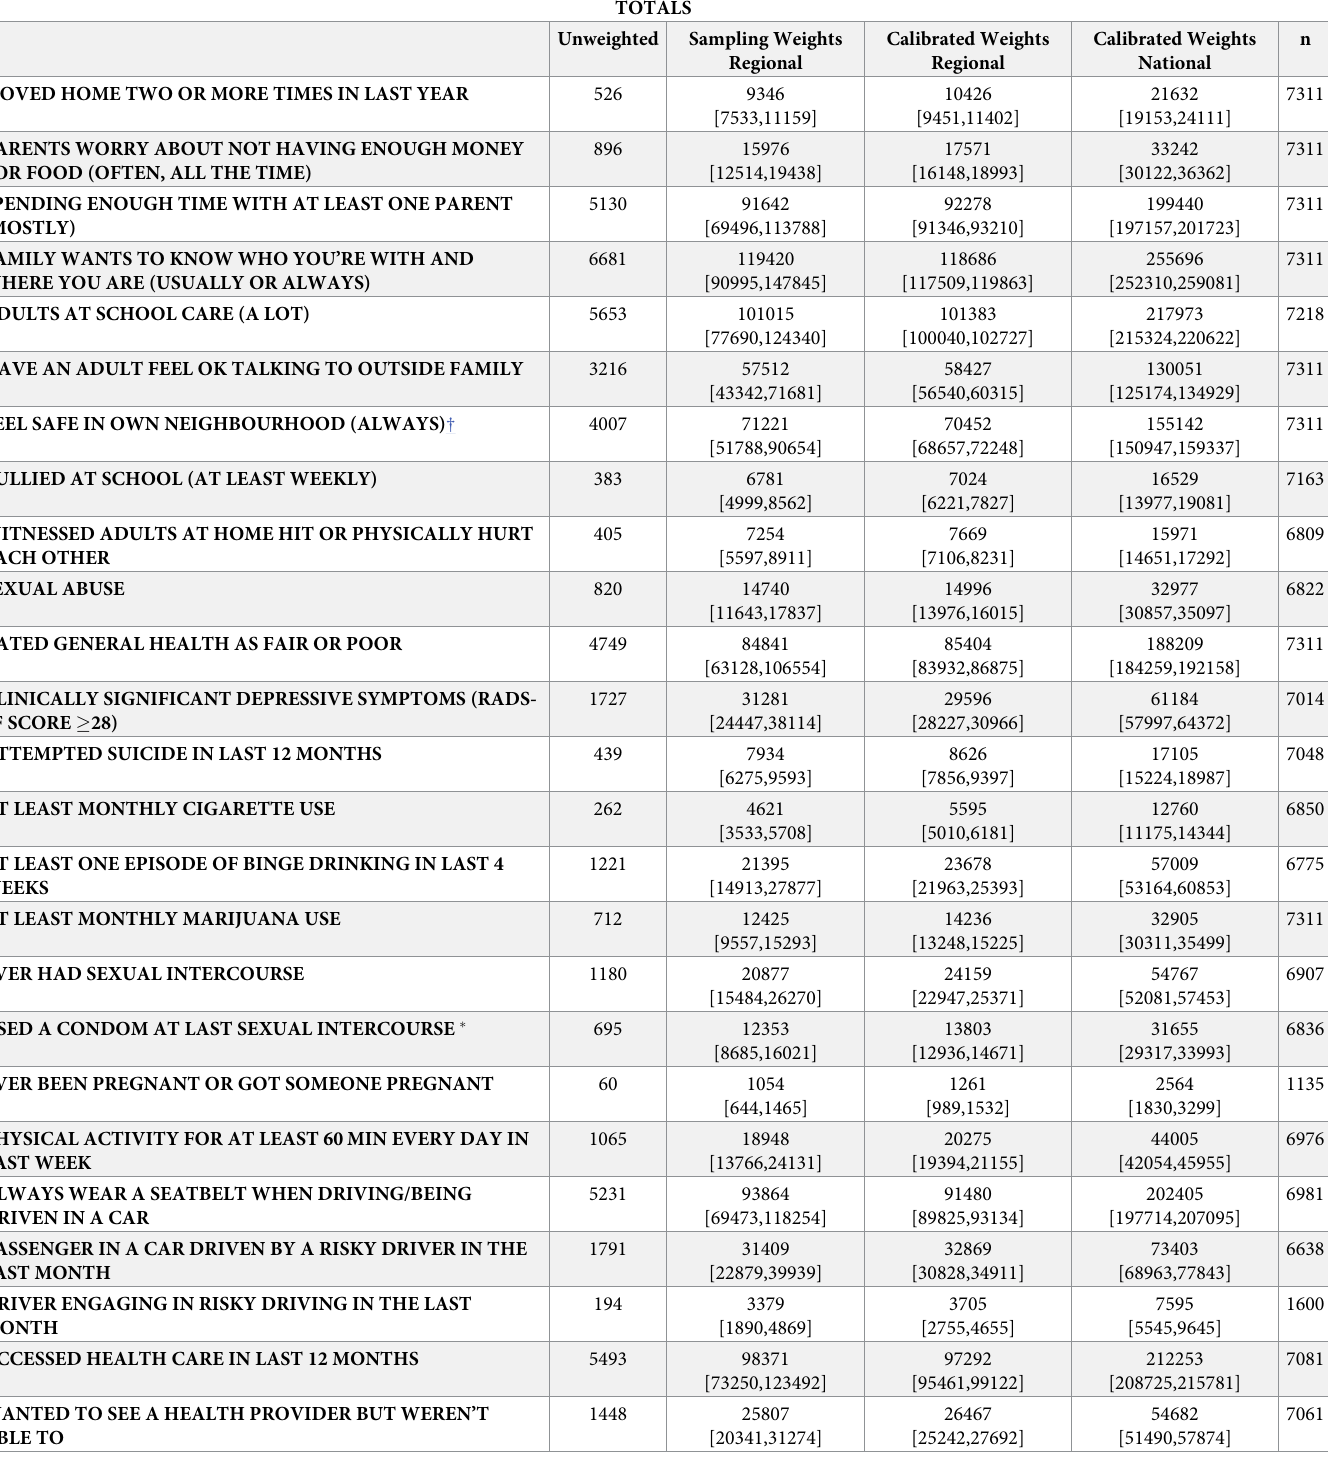
Table 5. Estimates of total student numbers for health and wellbeing